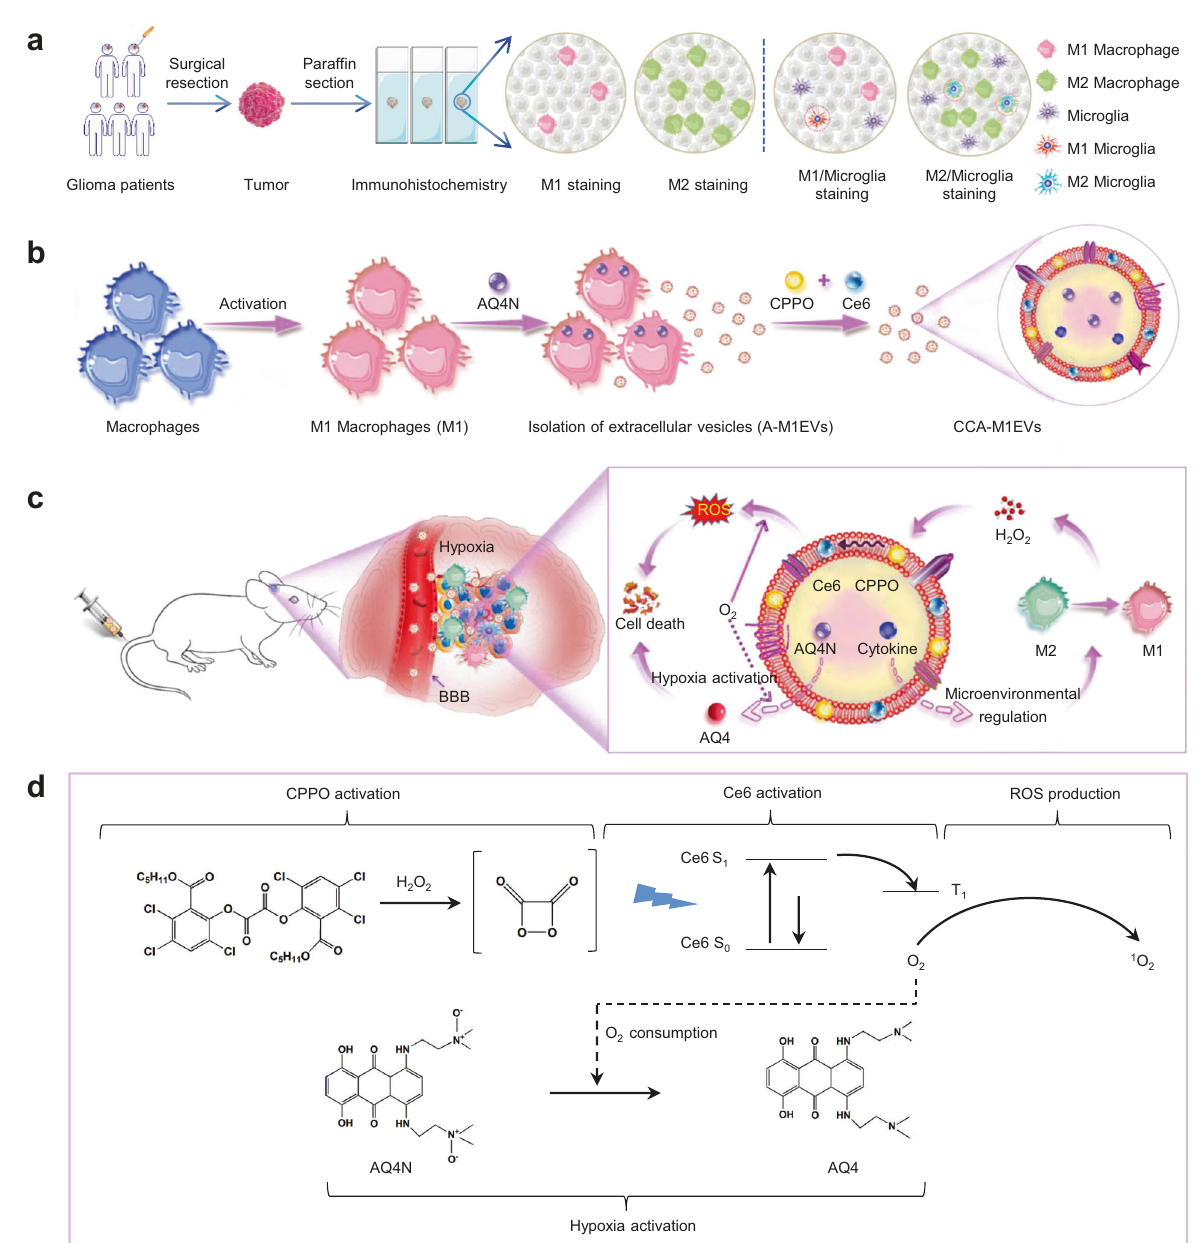
c . Accumulation in gliomas and synergism of immunomodulation, chemiexcited photodynamic therapy, and hypoxia-triggered chemotherapy of CCA-M1EVs in a murine model of gliomas. d . Corresponding illustration of chemical reactions induced by